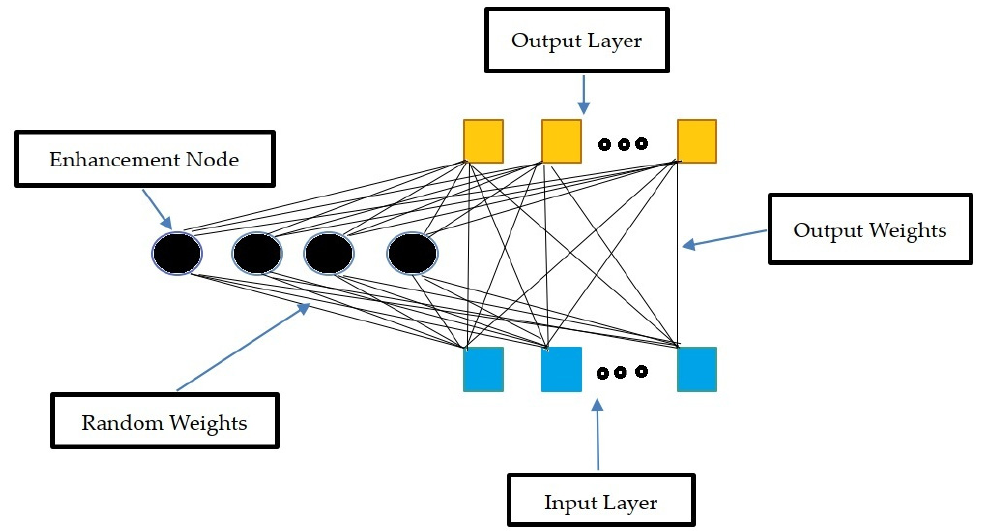
Figure 2. Schematic structure of RVFL (adopted from [23].